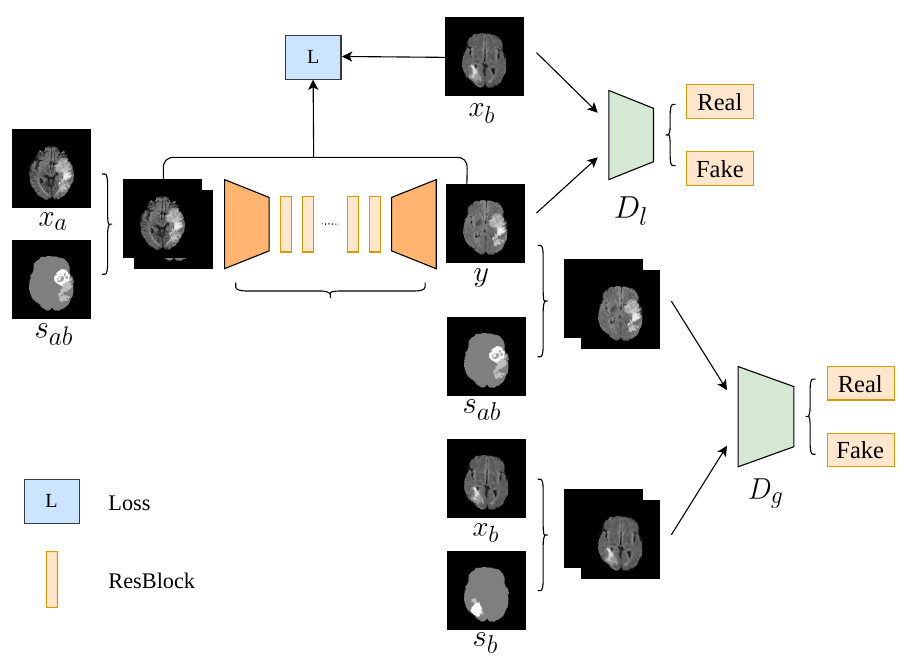
Figure 2. TumorGAN architecture. We use one generator G and two discriminators D g and D l .